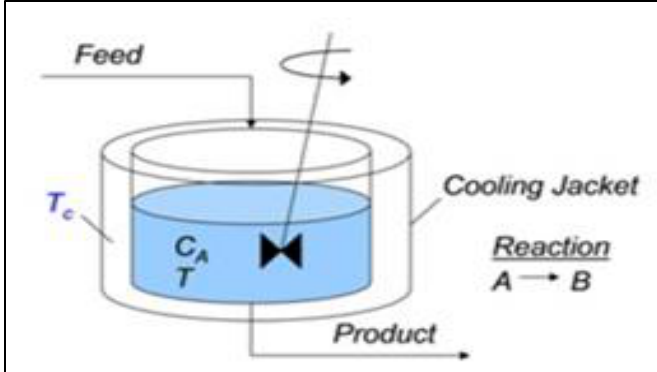
Figura 2: Diagrama espacial del reactor químico CSTR con camisa de enfriamiento y reacción simple exotérmica. Fuente: Los Autores,